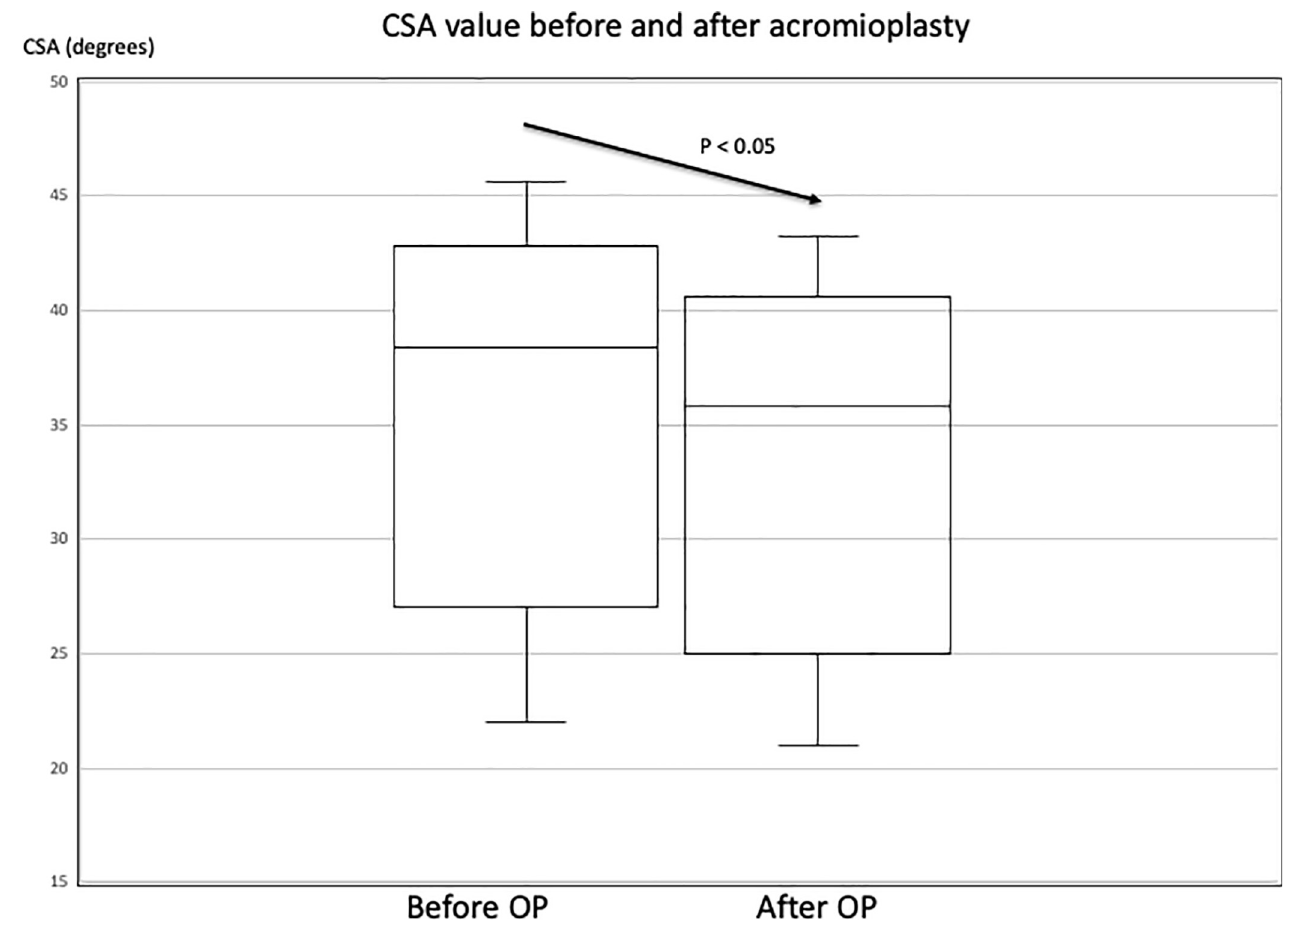
Fig 4. Critical shoulder angle before and after anterolateral acromioplasty. https://doi.org/10.1371/journal.pone.0253282.g004 RCTs and CSA [26]. Hence, surgical correction of the large CSA through acromioplasty can reduce the retear rate after RCTs repair surgery [20, 27]. A cadaveric study reported that arthroscopic lateral acromioplasty can reduce the CSA by 1.4˚ ± 0.6˚ [15]. The present study reports more obvious changes in the CSA with an average reduction of 2.6˚. Among the pres- ent patients with RCTs with CSA � 38˚, the CSA could be reduced in 57 patients within the previously reported threshold value [23]. Anterolateral acromioplasty can help achieve a safer CSA among individuals with RCTs to reduce the postsurgical retear risk. Table 2. Critical shoulder angle (CSA) changes after acromioplasty among all the participants and subgrouping by CSA of 38 degrees.